Question: Write a single sentence explaining what this figure depicts.
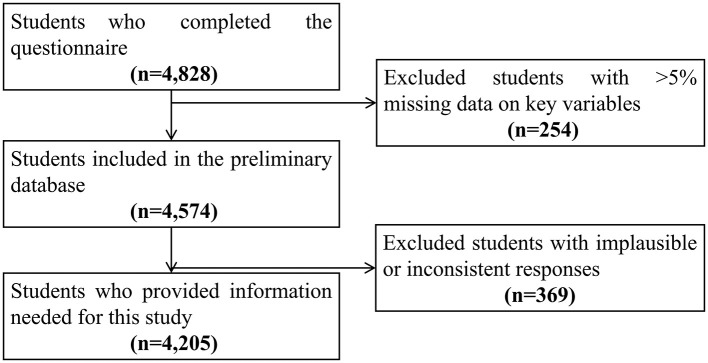
Answer: Detailed process used for cleaning invalid and missing data.